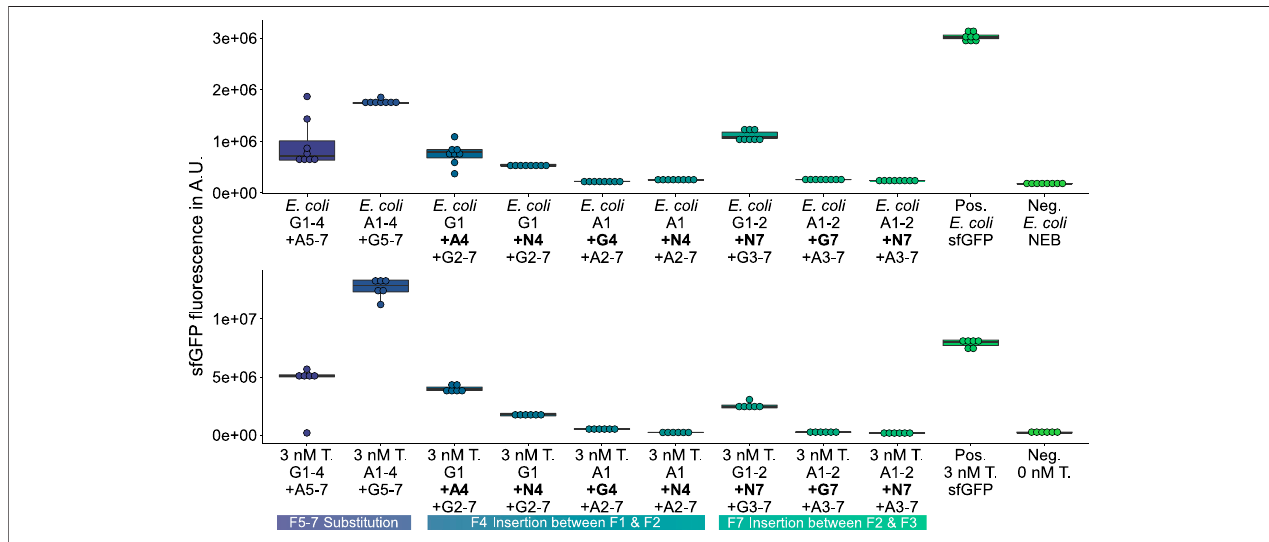
FIGURE 5 | GFP measurements validating constructs previously assembled and screened with HyperXpress. Top: E. coli in vivo validation of functional GFP- variants Pos.: E. coli expressing template plasmid; Neg.: E. coli carrying no plasmid ( n = 8). Bottom: in vitro validation using 3 nM of isolated plasmid DNA (T.) instead of the LCR in the HyperXpress work fl ow; Neg.: No Template DNA added ( n =